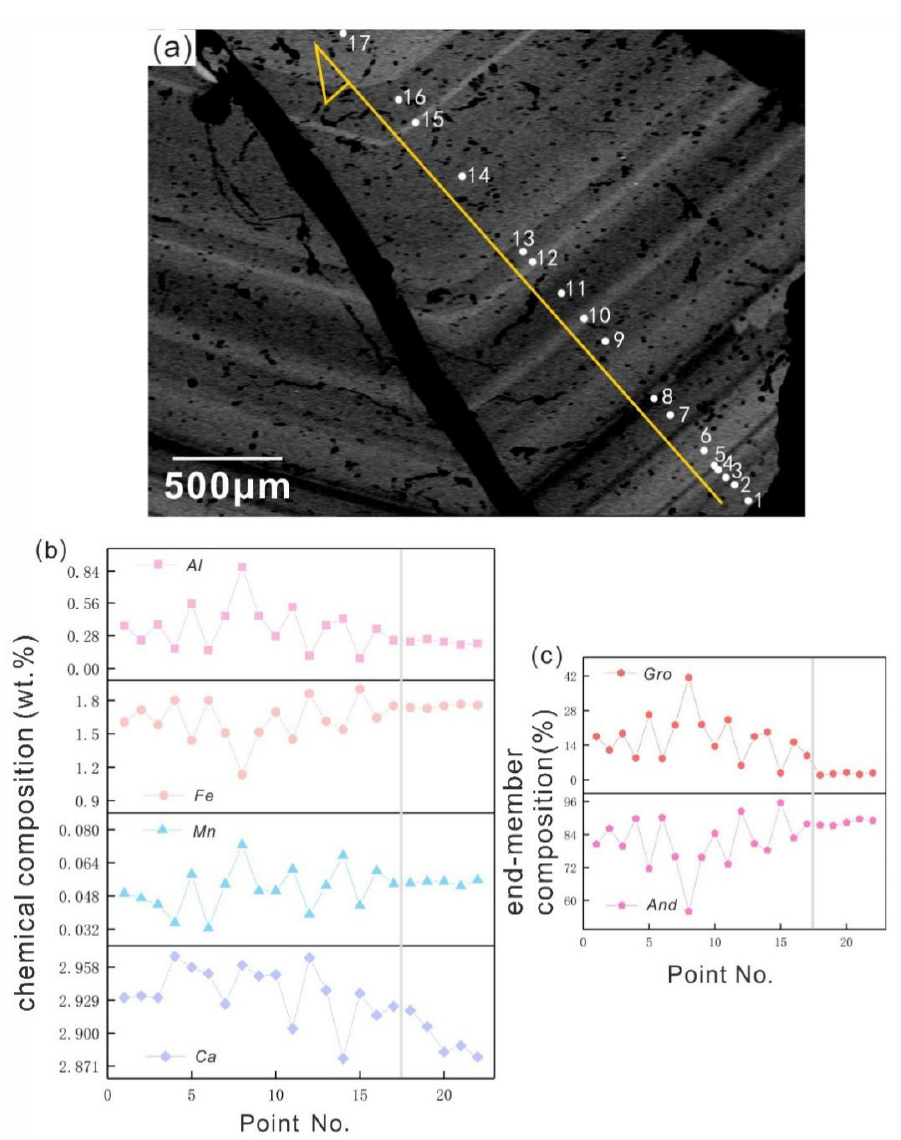
Figure 5. ( a ) Backscattered electron image displaying oscillatory zoning in garnet with alternating light and dark domains and the analytical points; ( b ) The major elements of 22 points of the oscillatory zoned rim and core; ( c ) The end-member compositions of 22 points of the oscillatory zoned rim and core. The left side of the vertical gray line is the oscillatory zoned rim, and the right side is the core.